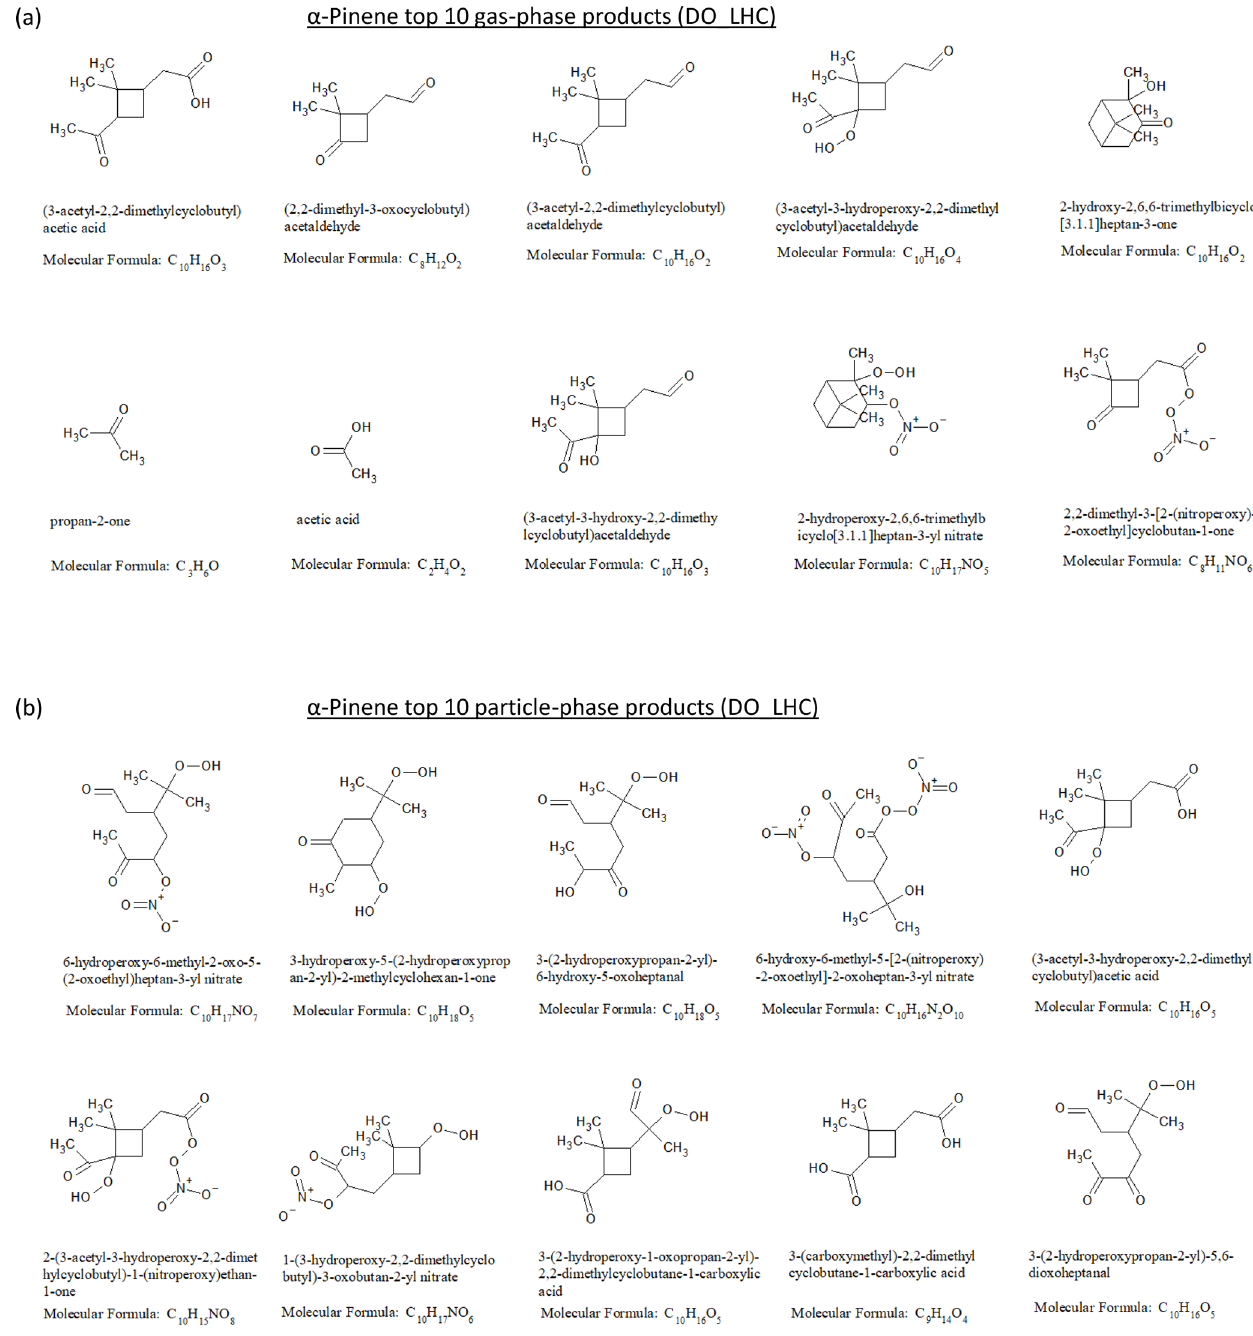
Figure 6. (a) Top 10 gas-phase products and (b) top 10 particle-phase products from α -pinene dark ozonolysis at the end of the low hydrocarbon (DO_LHC)